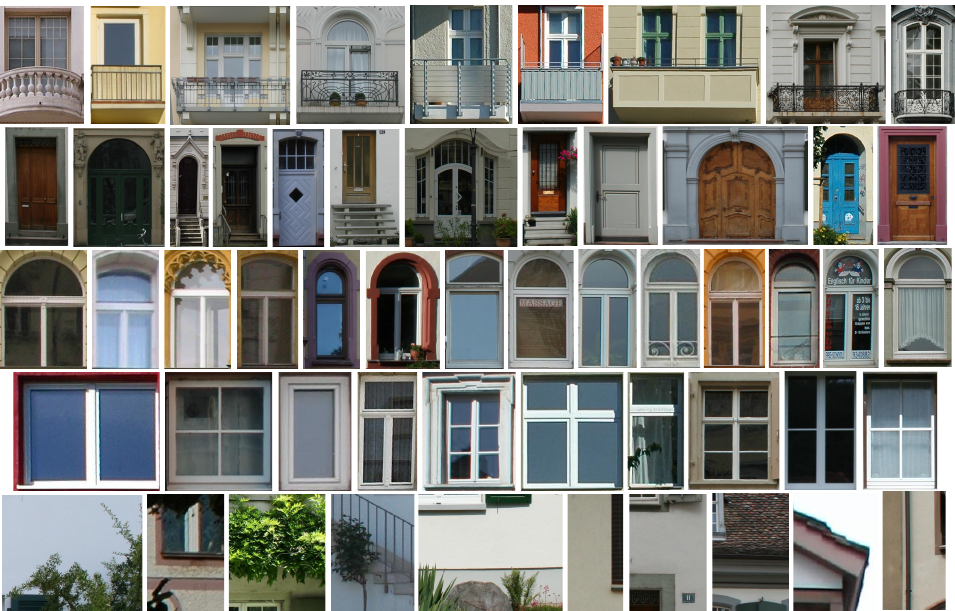
Figure 1: For each row some examples of given image sections for class balcony, entrance, arc-type windows, rectangular windows and background.